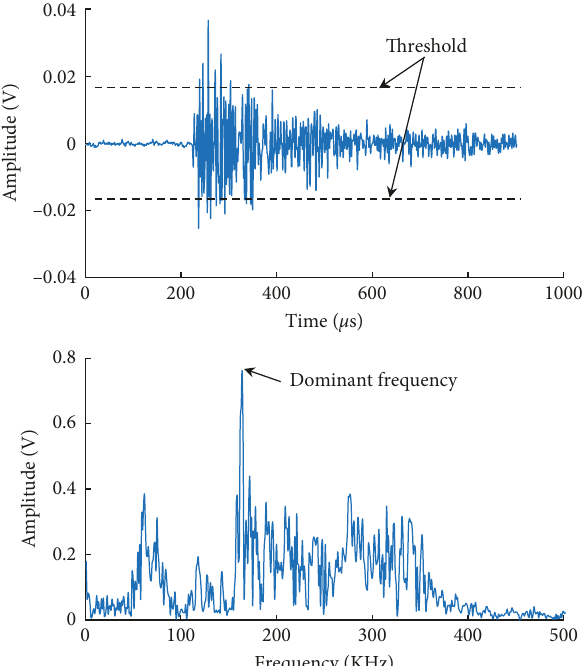
Figure 1: Schematic of AE hit in time domain and frequency